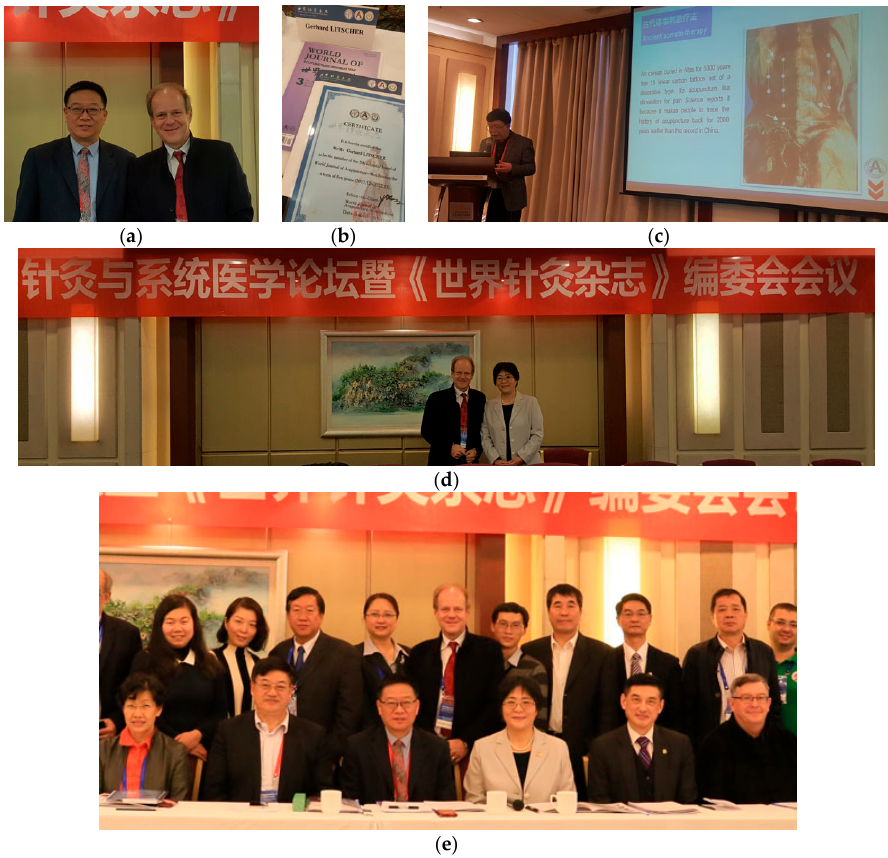
Figure 32. ( a – e ) Fifth (2017—2021) Editorial Board of the World Journal of Acupuncture (WJAM):